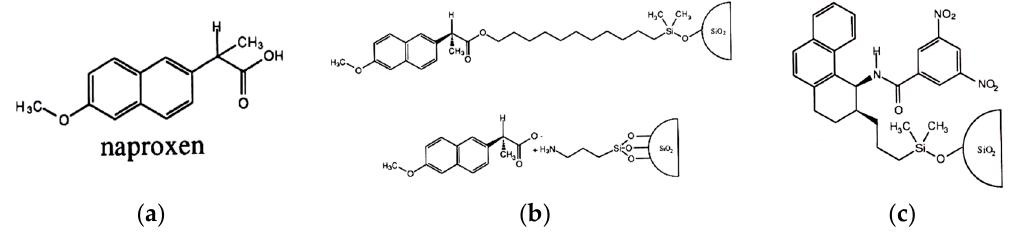
Figure 3. ( a ) Structure of naproxen; ( b ) A single enantiomer of naproxen attached covalently or ionically on silica; ( c ) The optimized CSP Whelk-O1 (commercialized by Regis Chemical Co., Morton Grove, IL, USA). Reprinted (adapted) with permission from